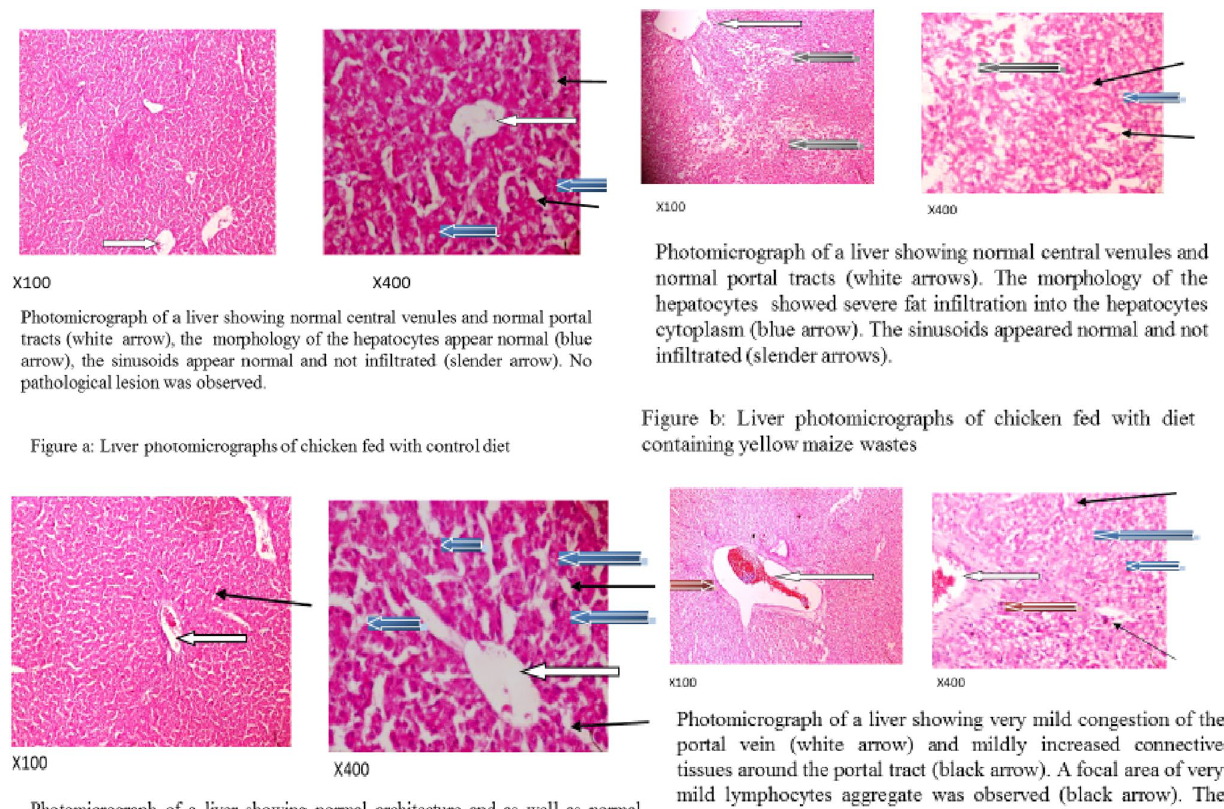
Fig. 1 a Liver photomicrographs of chicken fed with control diet. b Liver photomicrographs of chicken fed with diet containing yellow maize wastes. c Liver photomicrographs of chicken fed with diet con- taining mycomeat from yellow maize wastes using wild strain of P.